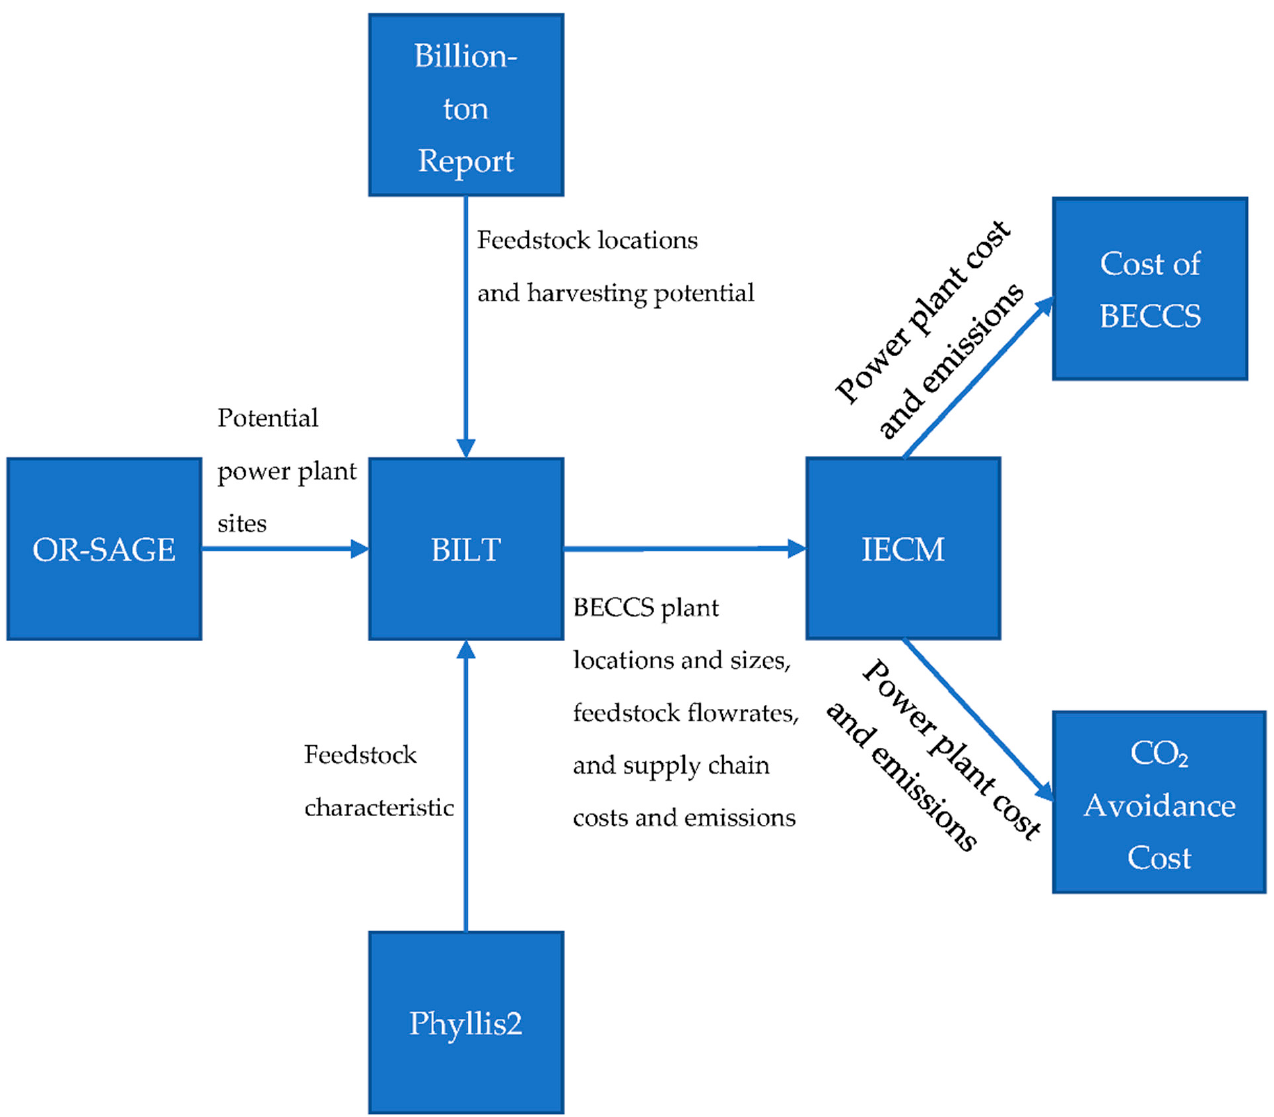
Figure 1. Information flow diagram describing the methodology of determining the cost of implementing BECCS.